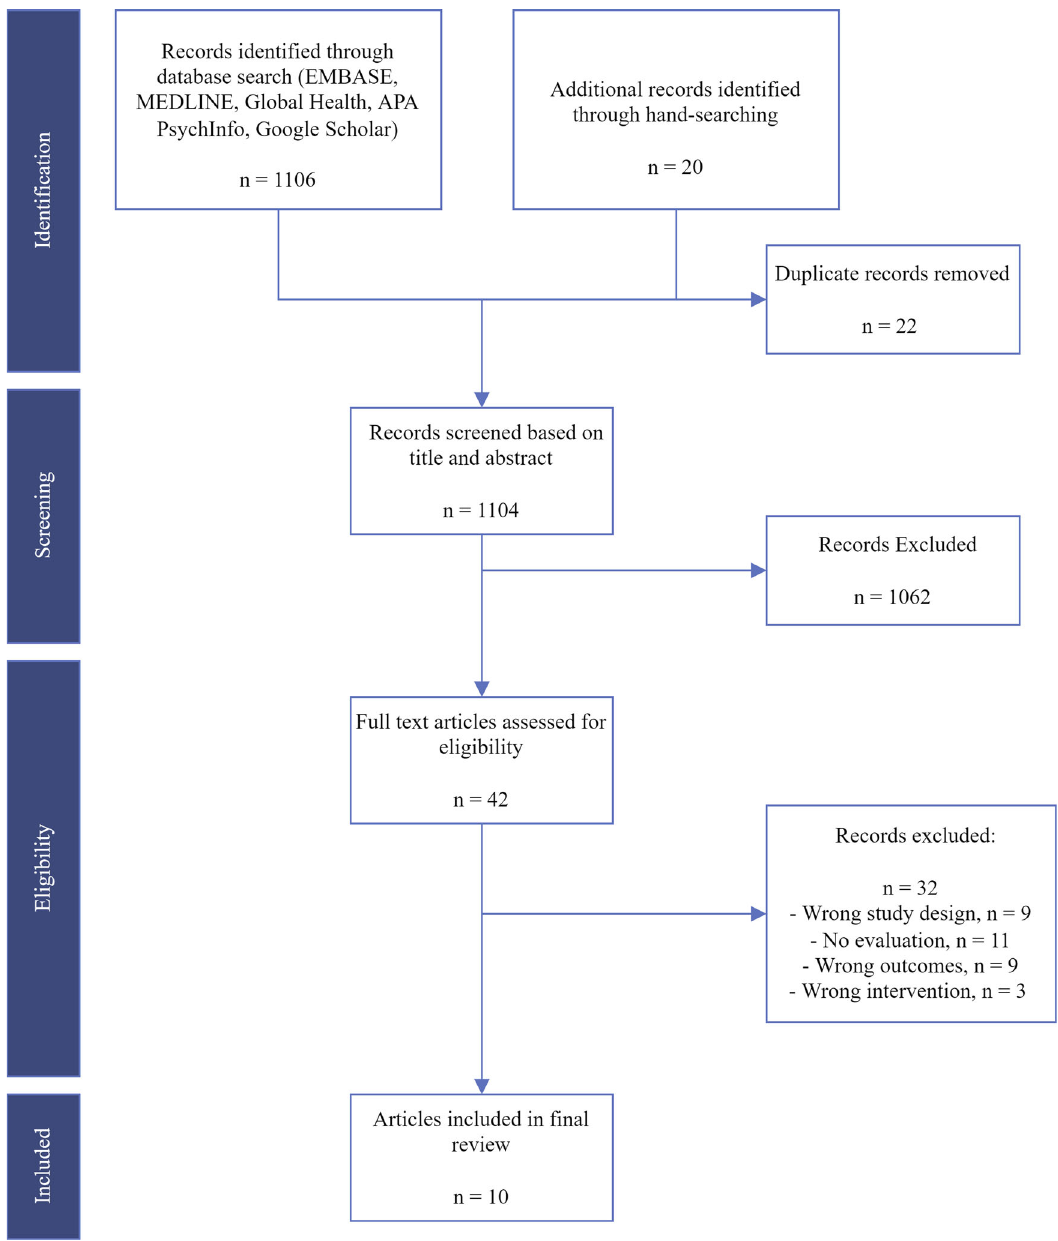
Fig. 1 PRISMA Flowchart of studies included in the systematic review. Flowchart of study identi fi cation, exclusion based on titles and abstracts, and inclusion in the fi nal review after assessing full